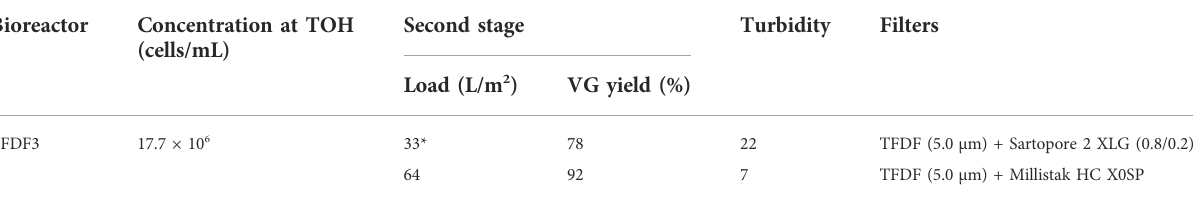
TABLE 4 Clari fi cation process using TFDF combined with second stage fi